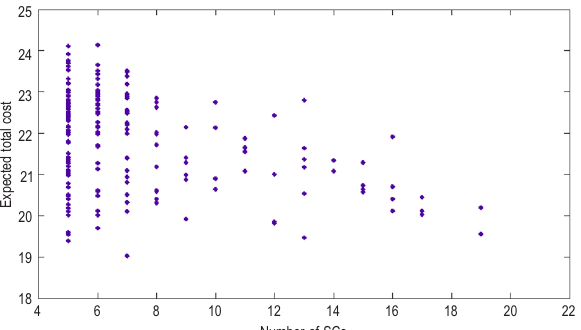
Fig. 7. The interaction of cost and number of SCs Choice No. 46 Risk =